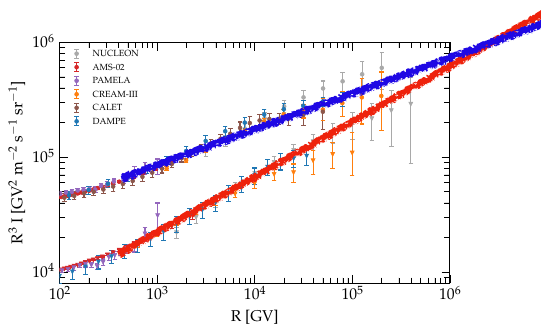
Figure 3. The He and proton spectra measured by various exper- iments. The blue and red lines are very wild extrapolations of the proton and Helium trends to higher energies. Data compiled by C. Evoli https: // github.com /